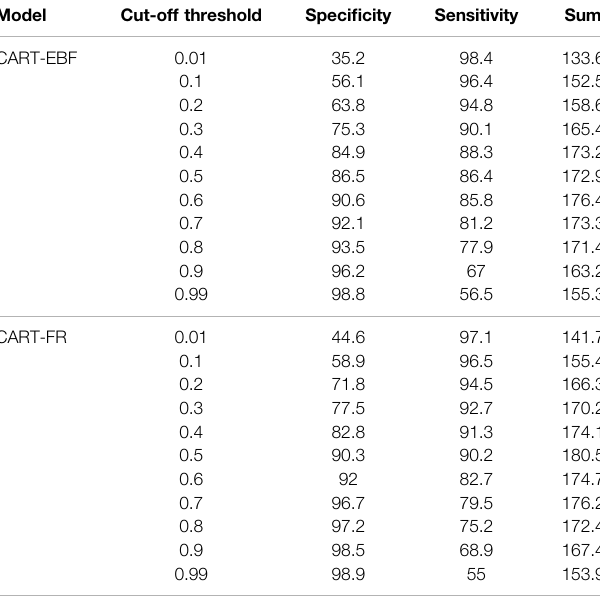
TABLE 4 | Speci fi city and sensitivity values using different cut-off thresholds.